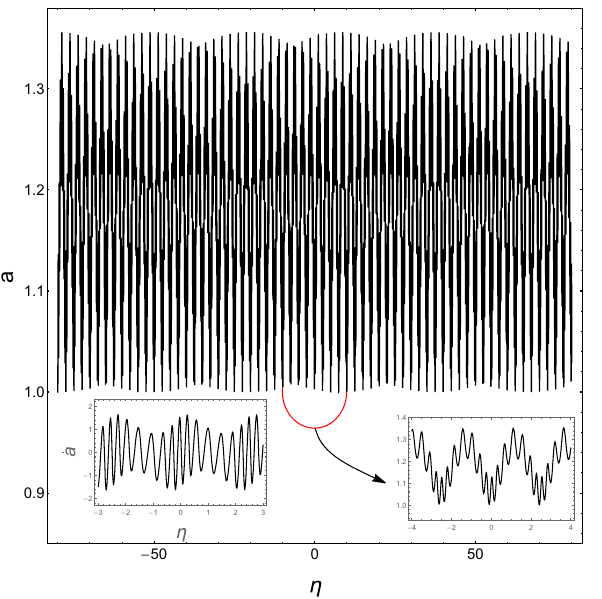
Z 0 = 0 . 3117 and Q 0 = − 0 . 00152. The right insets show the behavior of a and (cid:3) within a shorter time interval and the left ones are plotted for time derivatives of these quantities